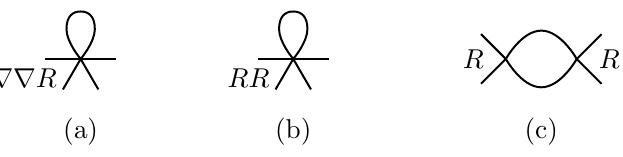
Figure 3 . One-loop contributions to the 1PI four-point vertex: (a) Single Wick contractions of the rr R six-point vertices; (b) Single Wick contractions of RR six-point vertices; (c) Diagrams involving only four-point